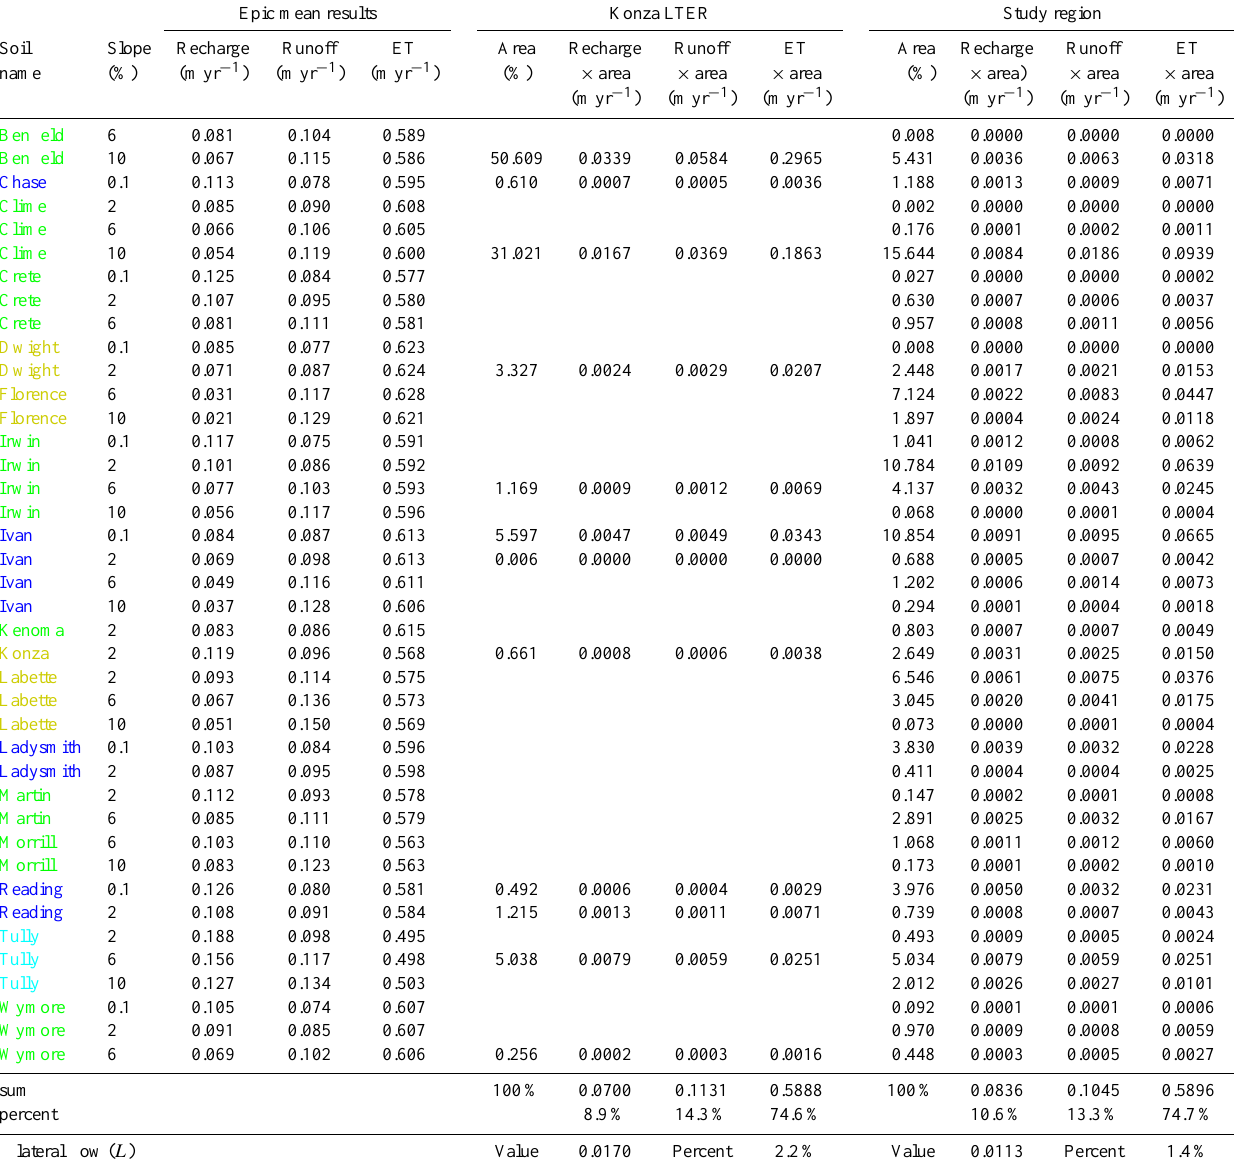
Table 3. Average recharge on Konza and the region by spatially averaging over the flood plains and terraces, foot slopes, side slopes, and benches and interfluves. Note that soil names are colored in the first column to help identify their position in the landscape. Epic mean results Konza LTER Study